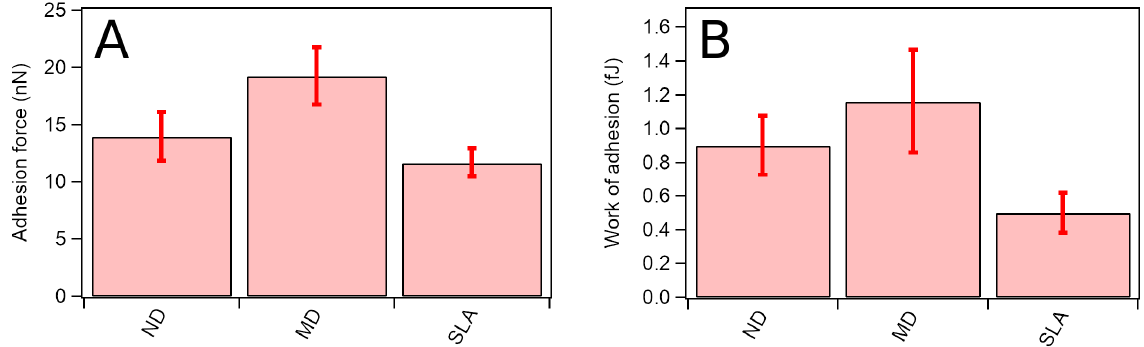
Figure 3. Adhesion forces ( A ) and adhesion work ( B ) measured between the silicon AFM tip and ND, MD, and SLA surfaces. The cantilever used was a PPP-Cont from Nanosensors with stiffness equal to k = 0.1 Nm − 1 . Thirty force—distance curves were measured on each sample in order to determine adhesion values.